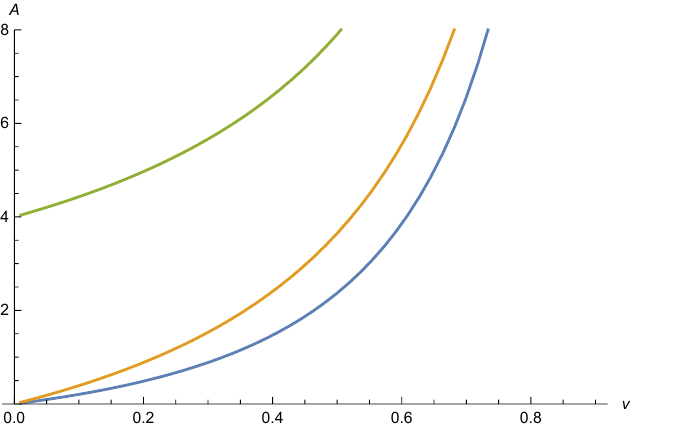
Figure 4. Dimensionless mass term ˜ m 2 as a function of x = ln ( ˜ ρ ) . The plot is for w = 0.06, using the parameters of Figure 2. For a location of the crossover at larger x , the height of the maximum decreases.